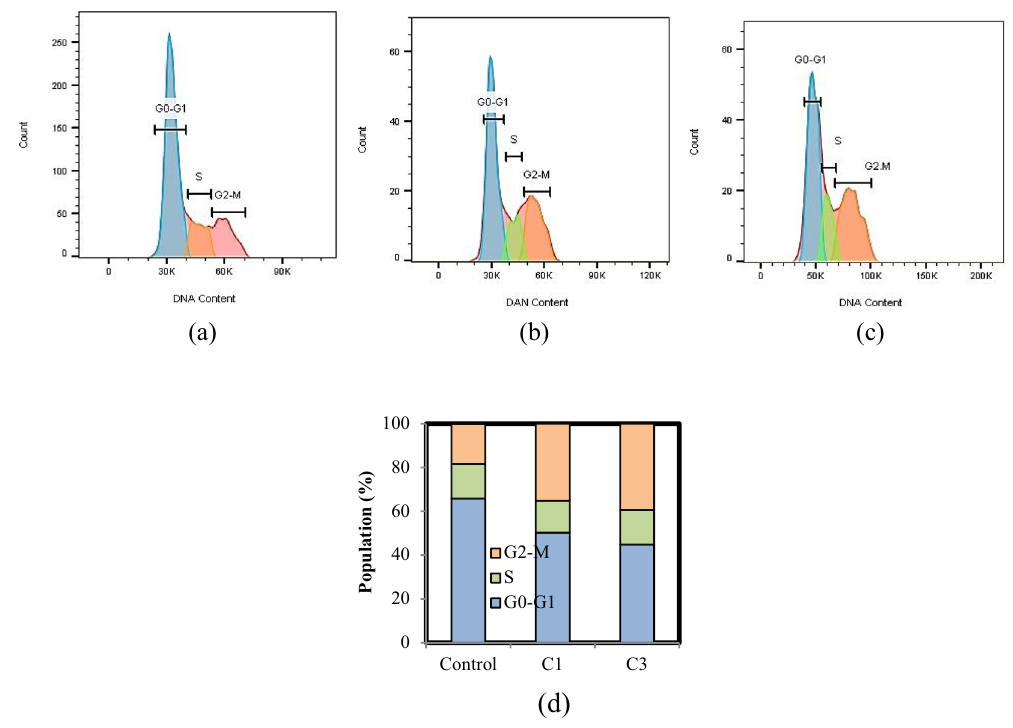
Figure 6. A375 cells were treated with ( a ) Vehicle control, ( b ) C1, and ( c ) C3 at IC 50 concentrations for 24 h, after which they were stained with PI and analyzed by flow cytometry. ( d ) Populations for cell cycle